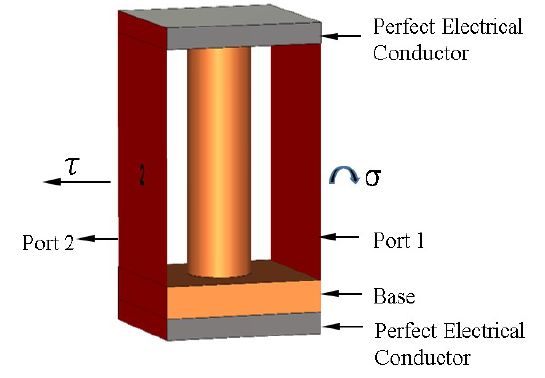
Figure 1. Cylindrical unit cell with perfect electrical